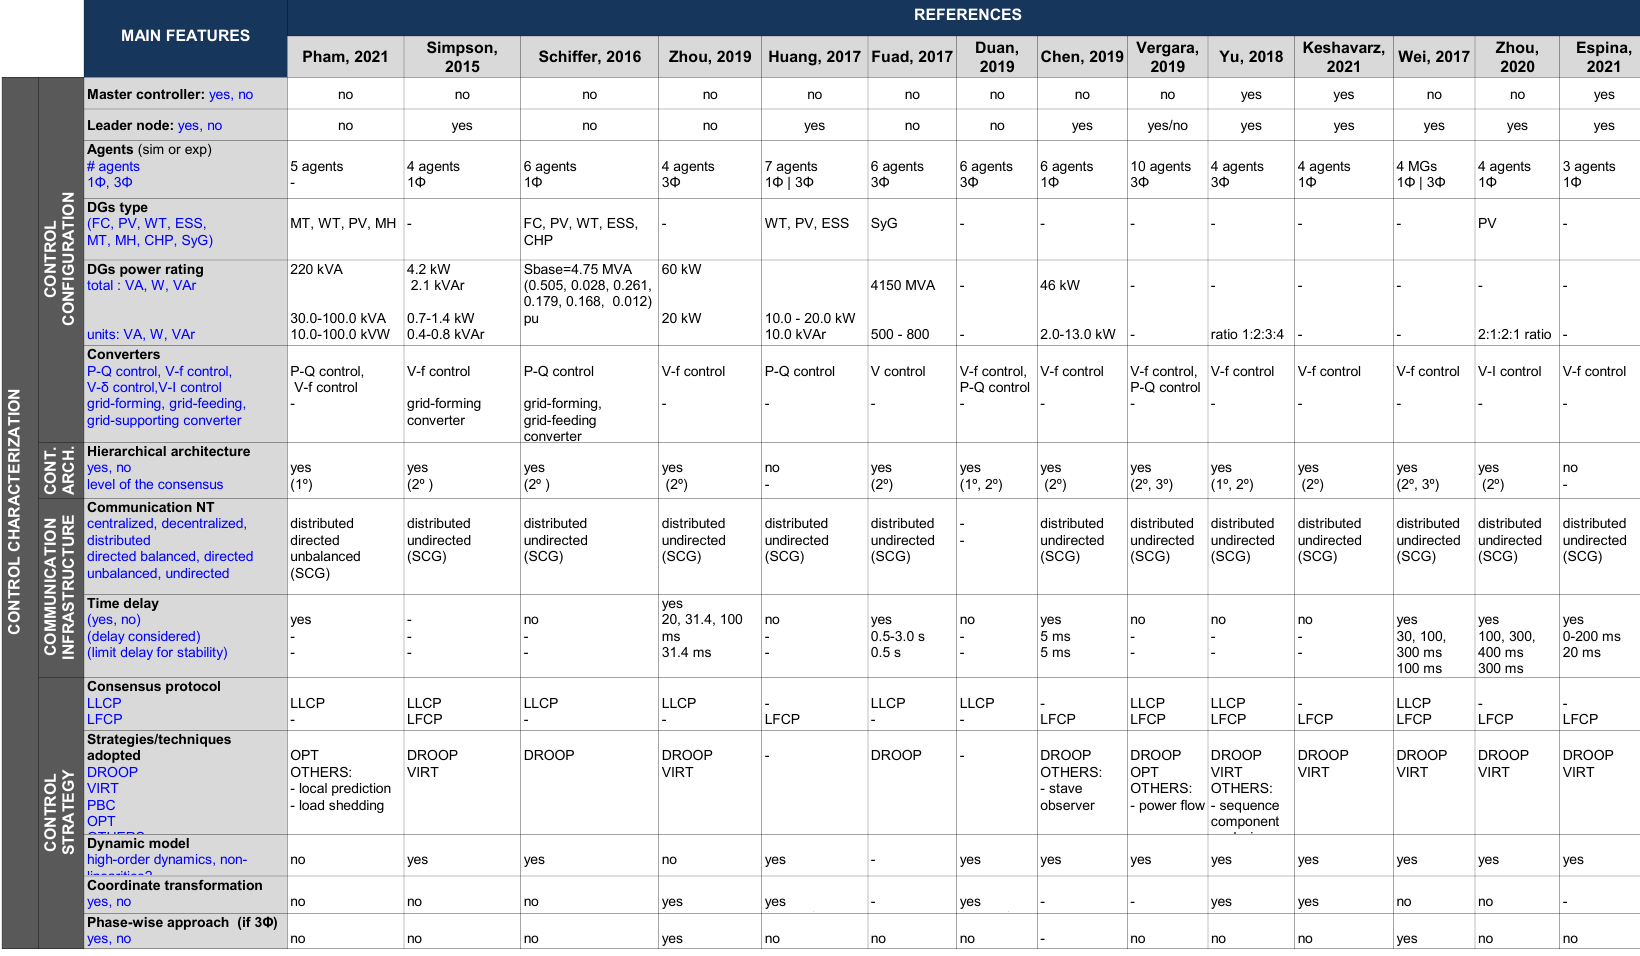
Figure 12. Publications on consensus-based control systems for MGs: control systems characterization—part 1. Legend: Pham, 2021 [111], SimpsonPorco, 2015